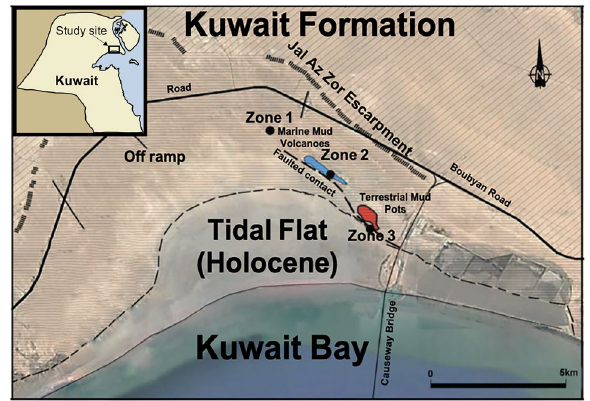
Figure 1. Aerial image from Google Maps showing Al-Subiya area in northern Kuwait. Sampling focused on 3 different lower Miocene outcrops, separated by Holocene remnant channels. Kuwait map (top-left) and the outline were created using Adobe Photoshop version 22.0.1 (https:// www. adobe.